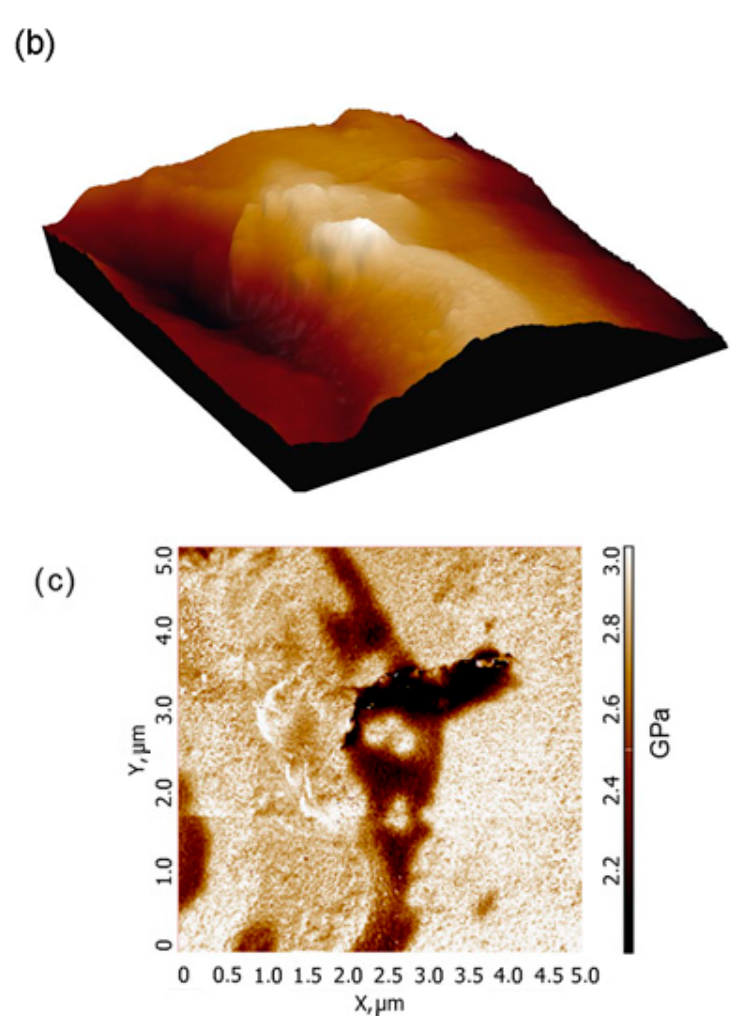
Figure 2. Topology ( a , b ) and Young modulus maps ( c ) of the In-Li (60 at% Li) alloy.